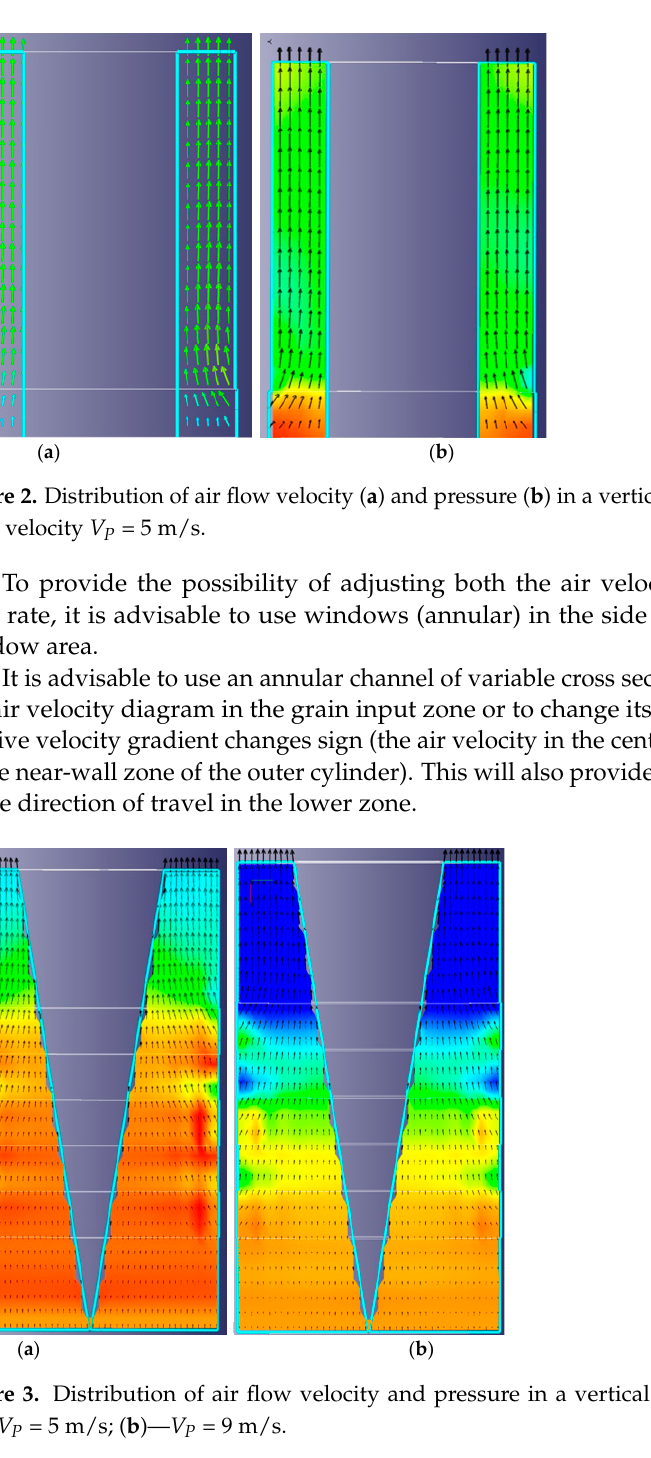
Figure 4. Scheme of a pneumatic gravitational separator ( a ) with options for supplying external air and a design scheme ( b ) for the force interaction of grains with an air flow: 1—air flow supply in the zone of grain material components coming off from the cone; 2—air flow supply in the zone of separation of grain material components according to their density; 3—air flow supply in the output zone of grain material fractions; I—output of the grain material fraction with the highest density (1350–1500 kg m − 3 ); II—output of the fraction of grain material with an medium density (1200–1350 kg m − 3 ); ІІІ —output of light fraction of grain material with density 500–1200 kg m − 3 . Without resorting to the technical details of the implementation of the directional field of air flow velocities, consider the option when an air flow is created in the middle (along the height) of the channel. This flow is characterized by an air speed distributed